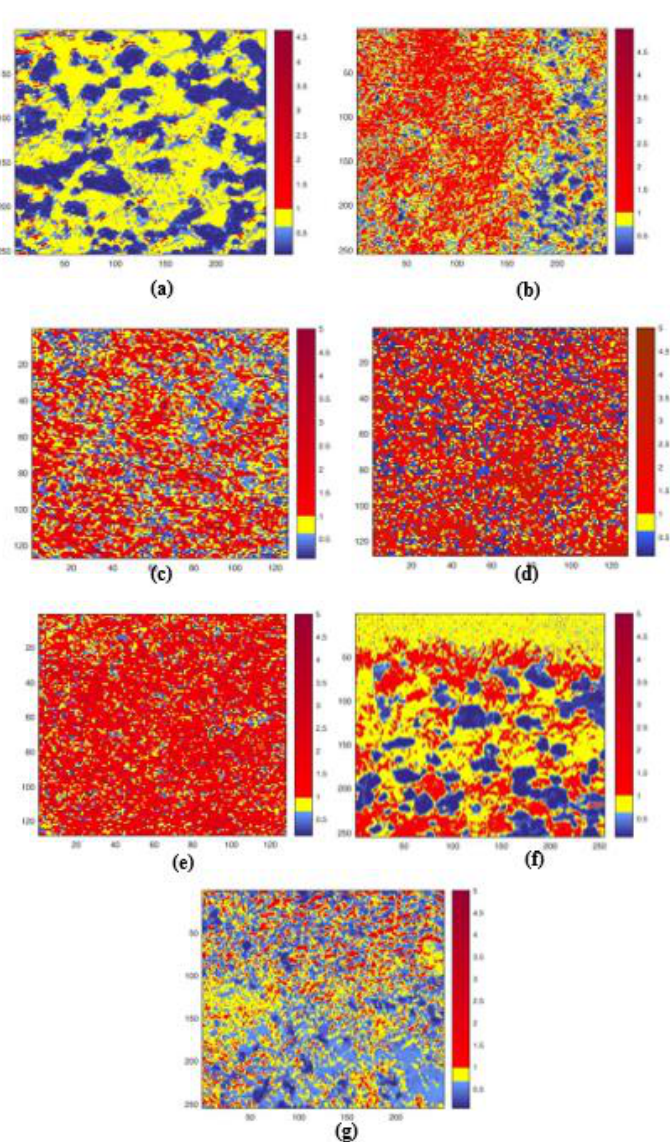
Figure 22. Scanning photoelectron microscopy (SPEM) images of the Pb/Bi atomic ratio (AR) distribution for the samples quenched at ( a ) 126 °C, ( b ) 200 °C, ( c ) 313 °C, ( d ) 401 °C, ( e ) 518 °C, ( f ) 518 °C (cross section of the sample), ( g ) 700 °C.